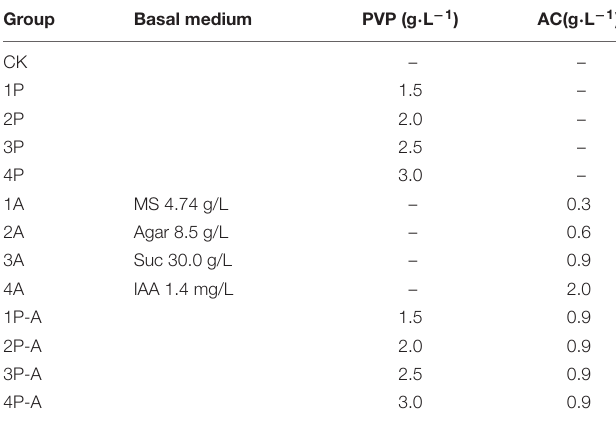
TABLE 1 | Composition of media for different treatment combinations. Group Basal medium